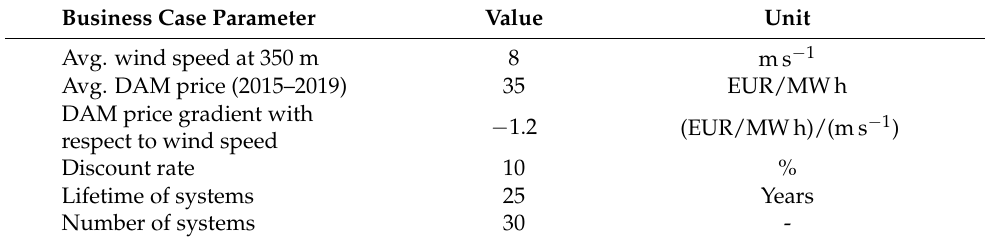
Table 3. Business case parameters.